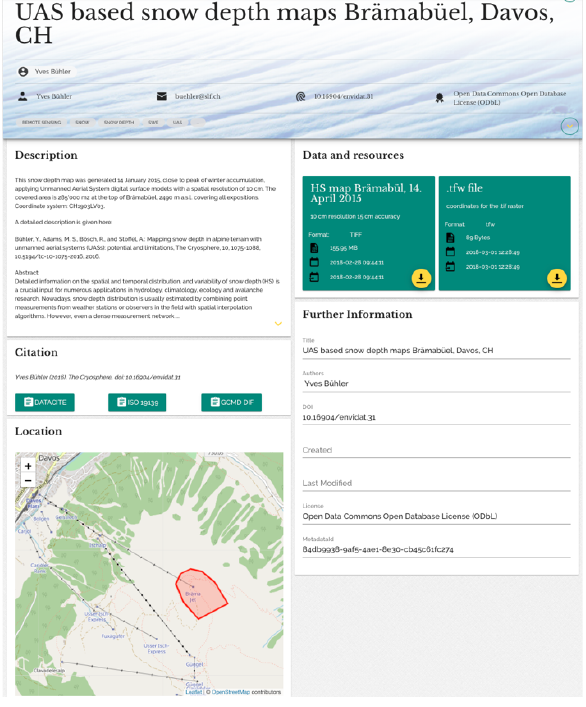
Figure 2. Example of a published data set in